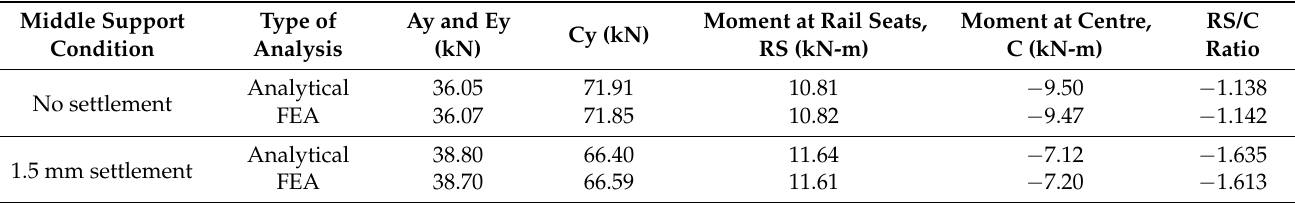
Figure 12. Validation of the analytical solution with finite element (FE) analysis. Table 5. Comparison of analytical and numerical